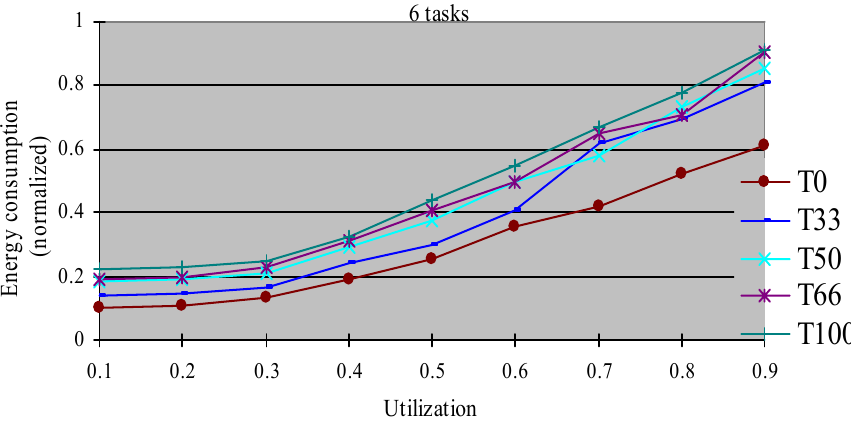
Figure 4. Normalized energy consumption at different task type ratio. 6